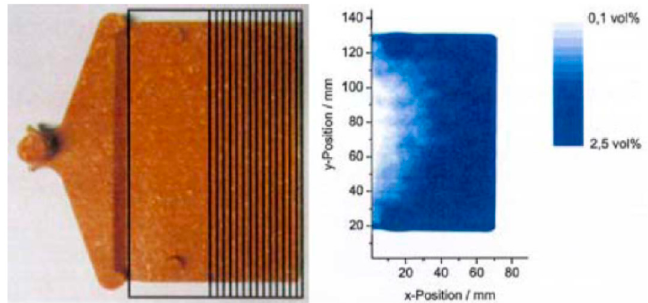
Figure 6. Photograph (left) and THz transmission image (right) of a wood/plastic composite material after immersion in water. From [32], courtesy of S. Wietzke, Continental AG.